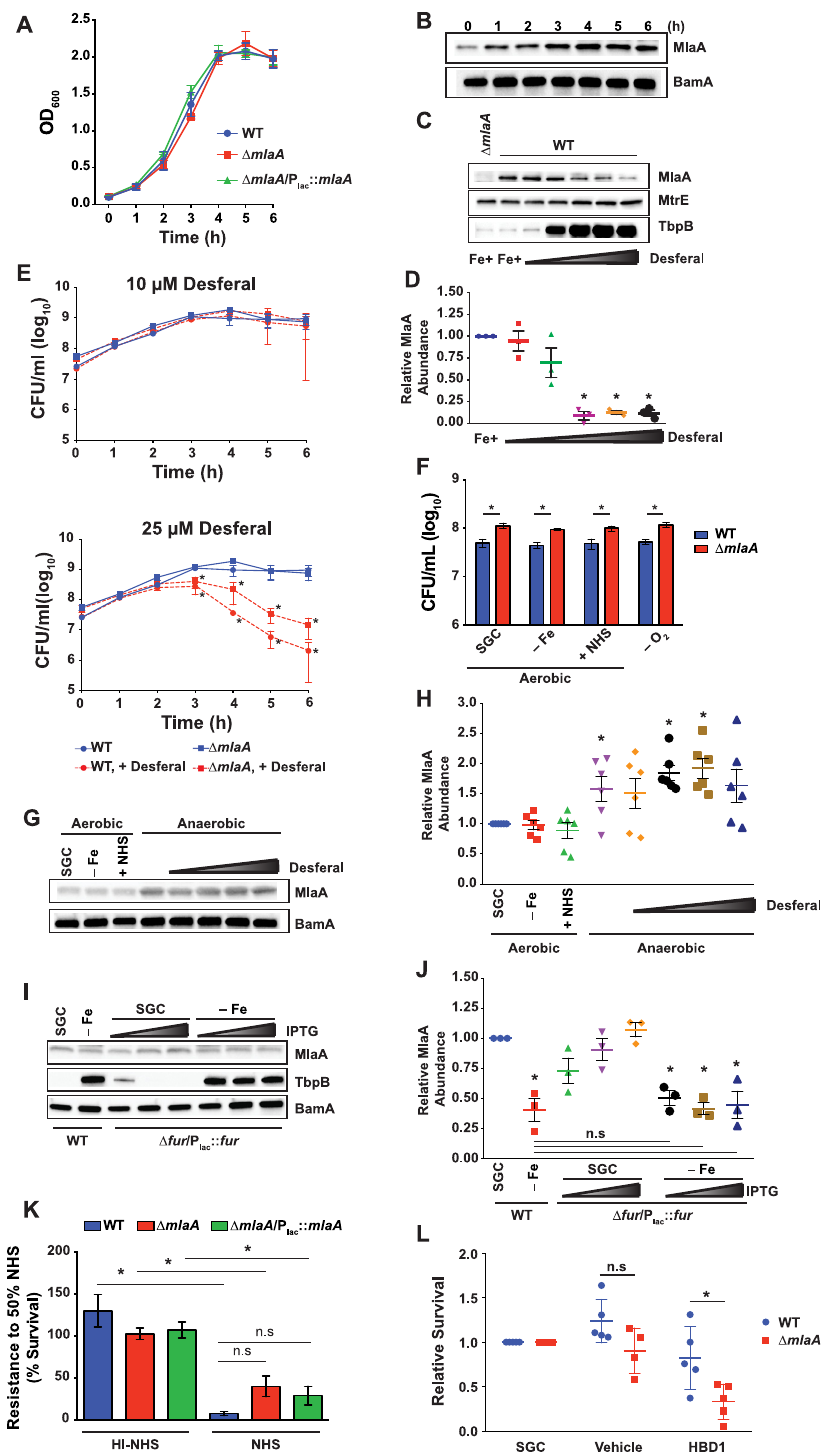
Fig 5. In vitro fitness assessments and MlaA expression profiling. (A) WT FA1090, isogenic knockout Δ mlaA , and complementation strain Δ mlaA /P lac :: mlaA were cultured aerobically in liquid medium. IPTG was added to 0.1 mM in Δ mlaA /P lac :: mlaA cultures. Bacterial growth was monitored every hour by OD 600 measurement. (B) Samples of WT FA1090 were collected at the times indicated. Whole cell lysates were separated by SDS-PAGE and probed with polyclonal rabbit anti-MlaA or anti-BamA (as a loading control) antisera. (C) Whole cell lysates of WT FA1090 were collected after 6 h culture in liquid medium containing desferal at concentrations ranging from 5–25 μ M. Samples